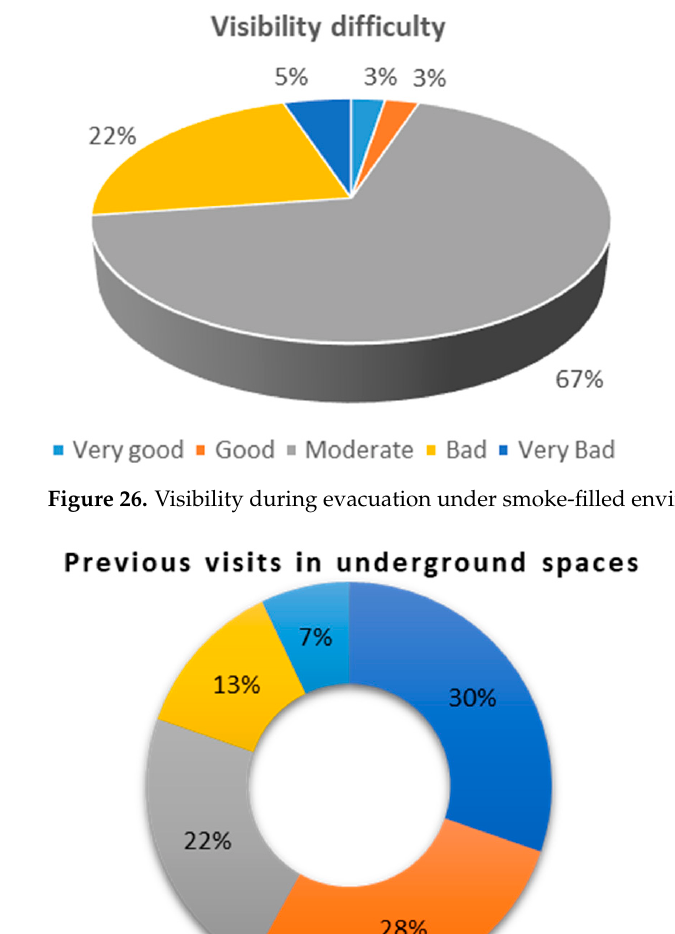
Figure 23. Difficulty during stairwell evacuation.